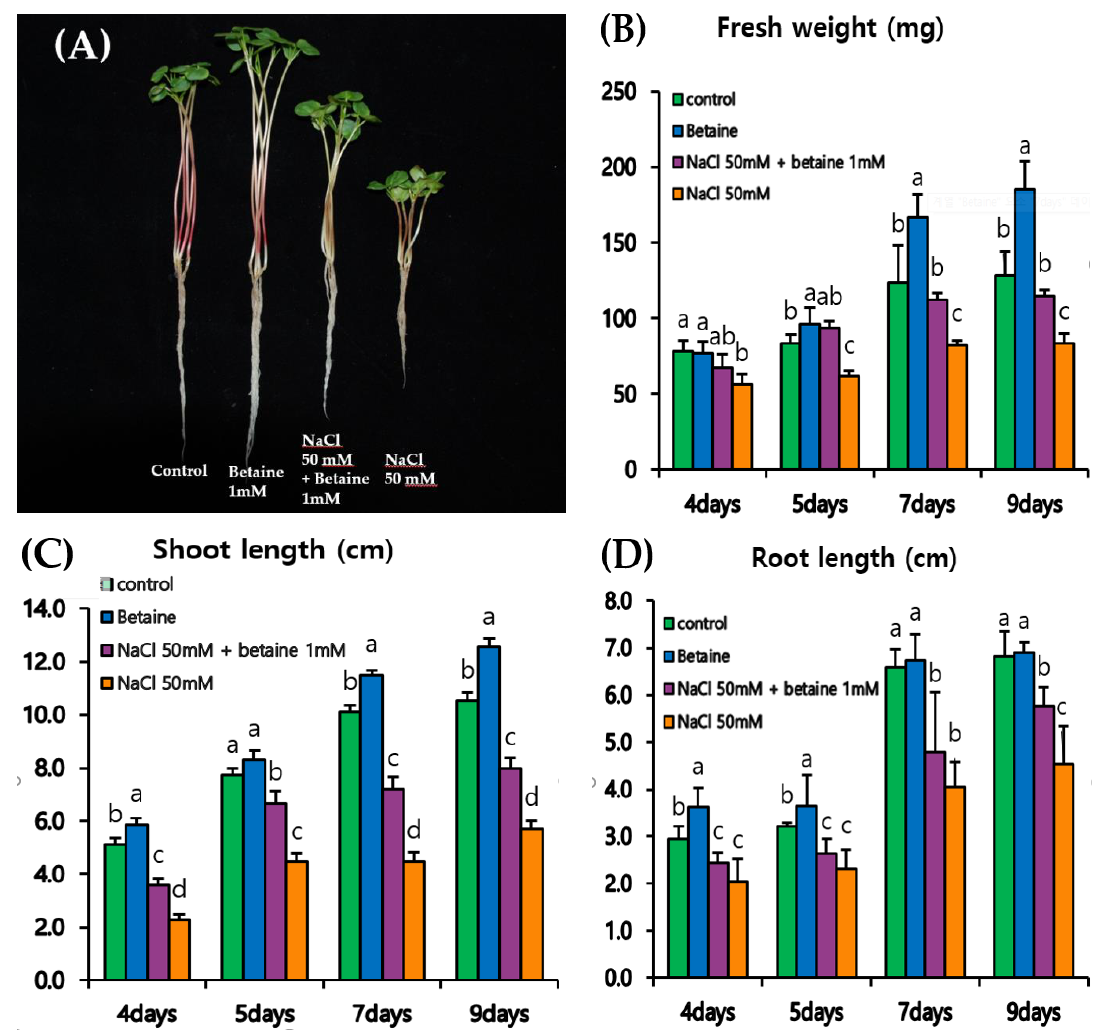
Figure 1. Time course of Tartary buckwheat sprout development after treatment of 50 mM NaCl and 1 mM betaine hydrochloride. Different letters indicate a significant difference ( p < 0.05) between areas for that parameter using DMRT (Duncan’s multiple range test; n ≥ 5, mean ± SD). ( A ) Picture of Tartary buckwheat sprouts at 9 days of betaine hydrochloride and NaCl treatment; ( B ) graph of fresh weight in treated Tartary buckwheat sprouts; ( C ) graph of shoot weight in treated Tartary buckwheat sprouts; ( D ) graph of root length in treated Tartary buckwheat sprouts.